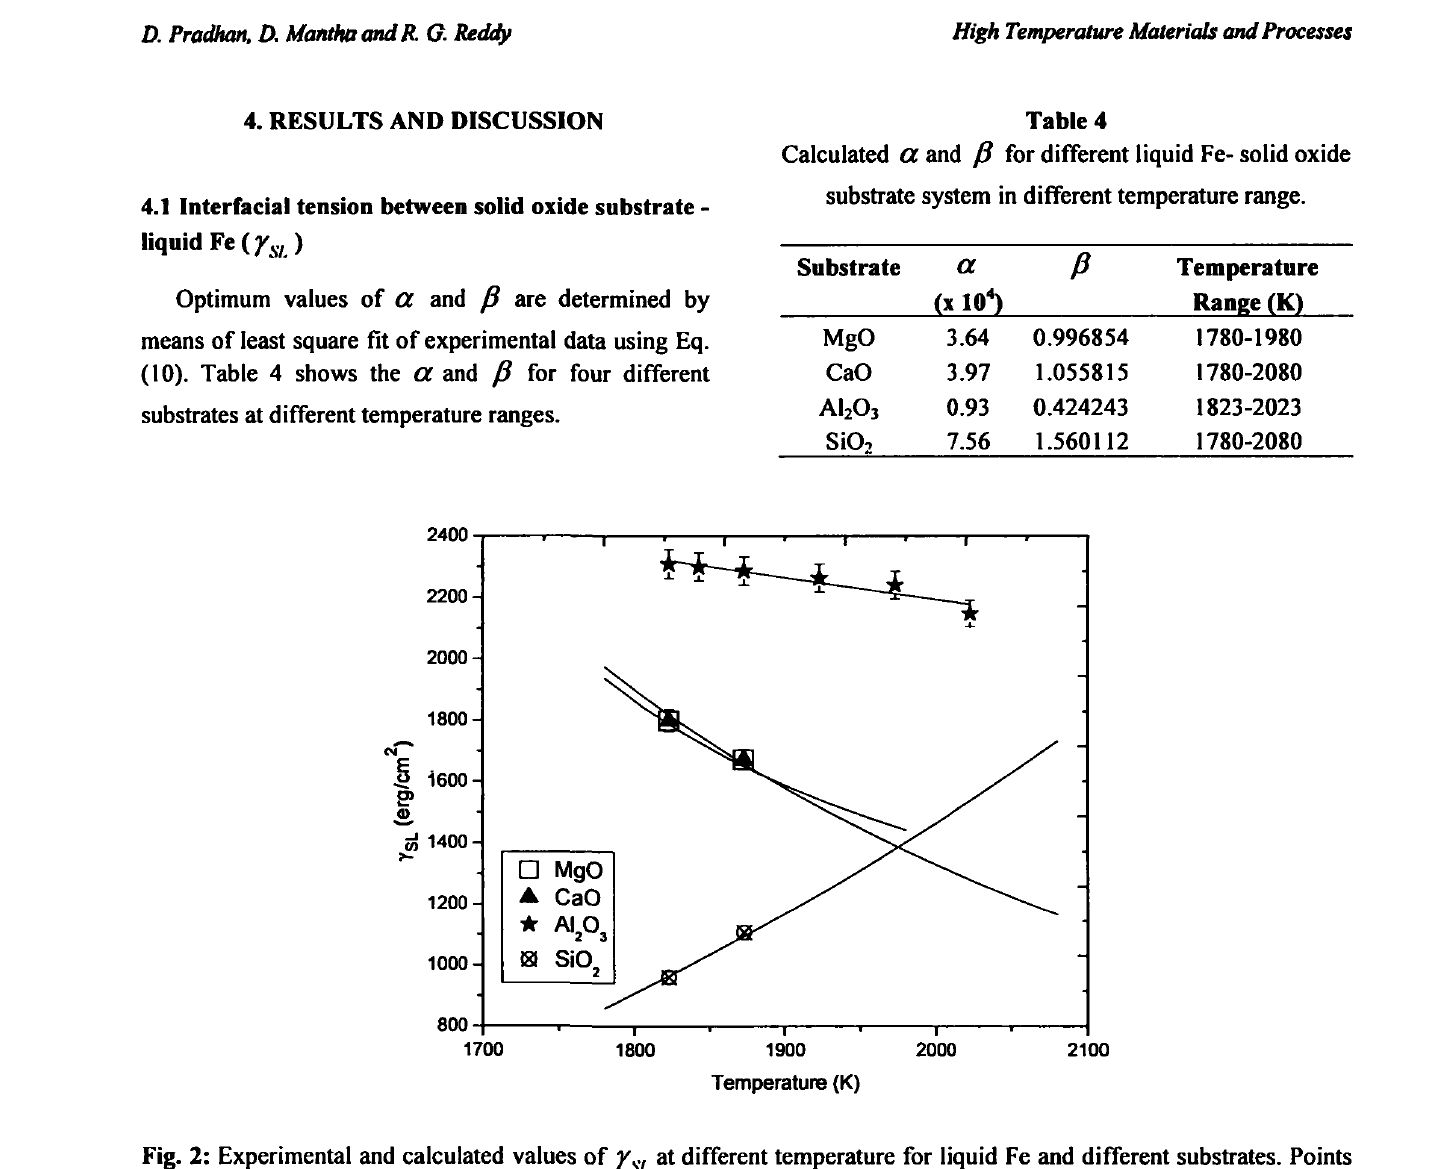
Fig. 2: Experimental and calculated values of y at different temperature for liquid Fe and different substrates. Points s/ represent the experimental data and solid lines represent calculated values using Eq.